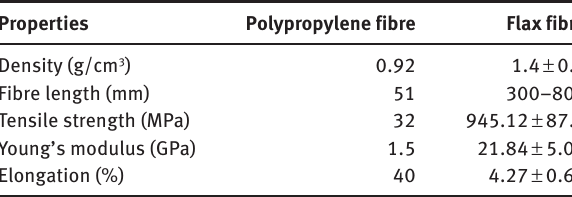
Table 1: The mechanical properties of polypropylene and flax fibres.